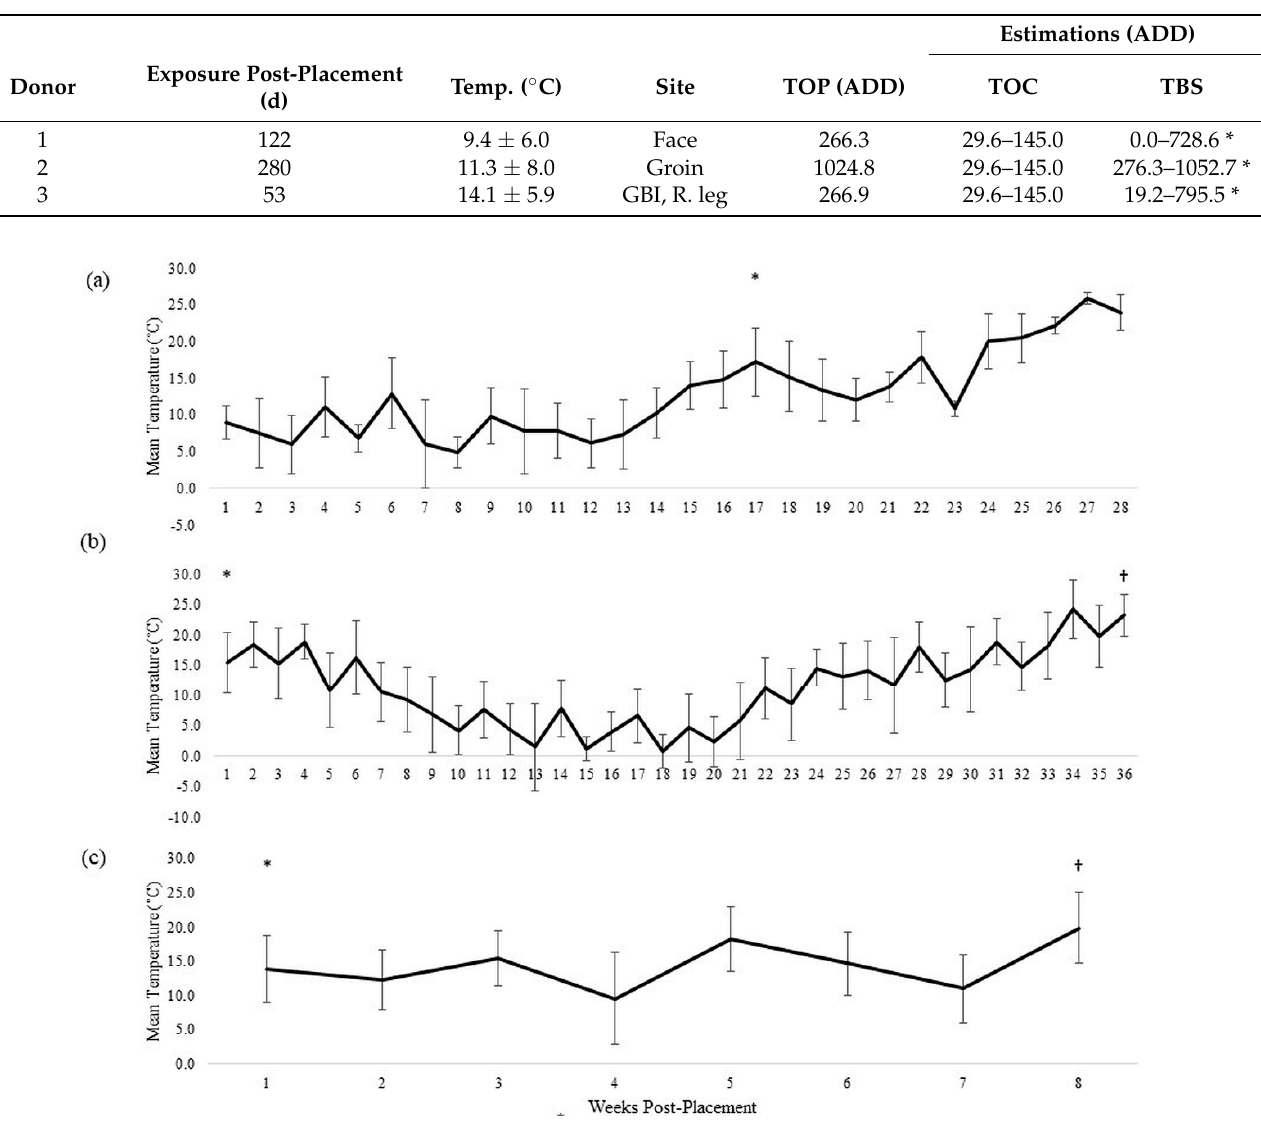
Figure 2. Mean (± standard deviation) temperature (in °C) for each week post-placement for each human donor used in this study. ( a ) Donor 1, ( b ) Donor 2, ( c ) Donor 3. * indicates the first observed blow fly colonization event. † indicates the first observed blow fly re-colonization event.